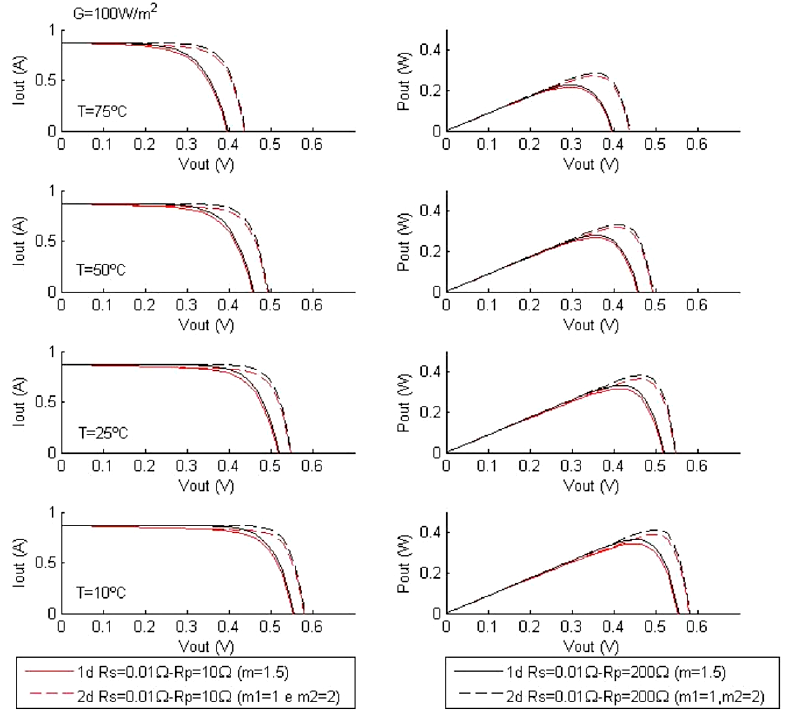
Figure 13. Characteristic curves of equivalent circuits of one and two diodes in function of temperature and parallel resistance R p , with a constant resistance R s (G = 100 W/m 2 ).